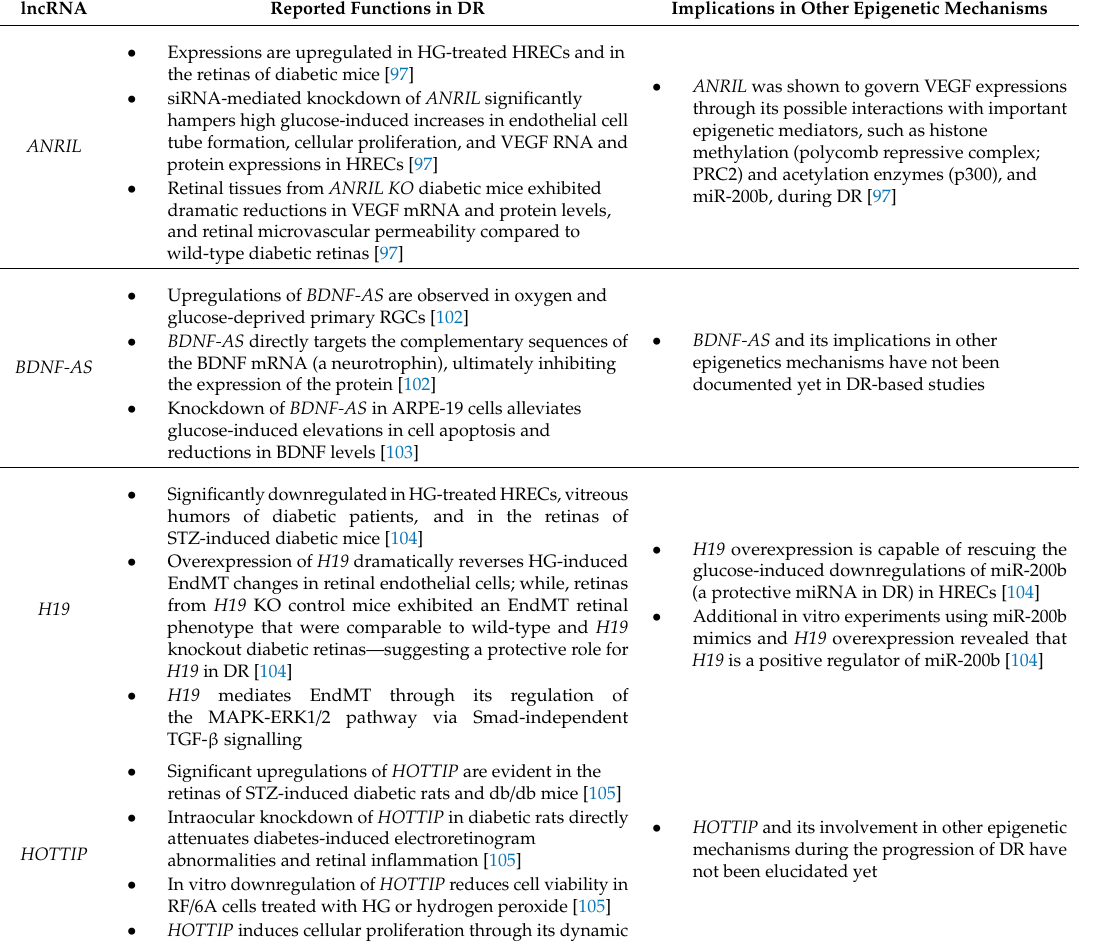
Table 1. Pertinent lncRNAs that are involved in